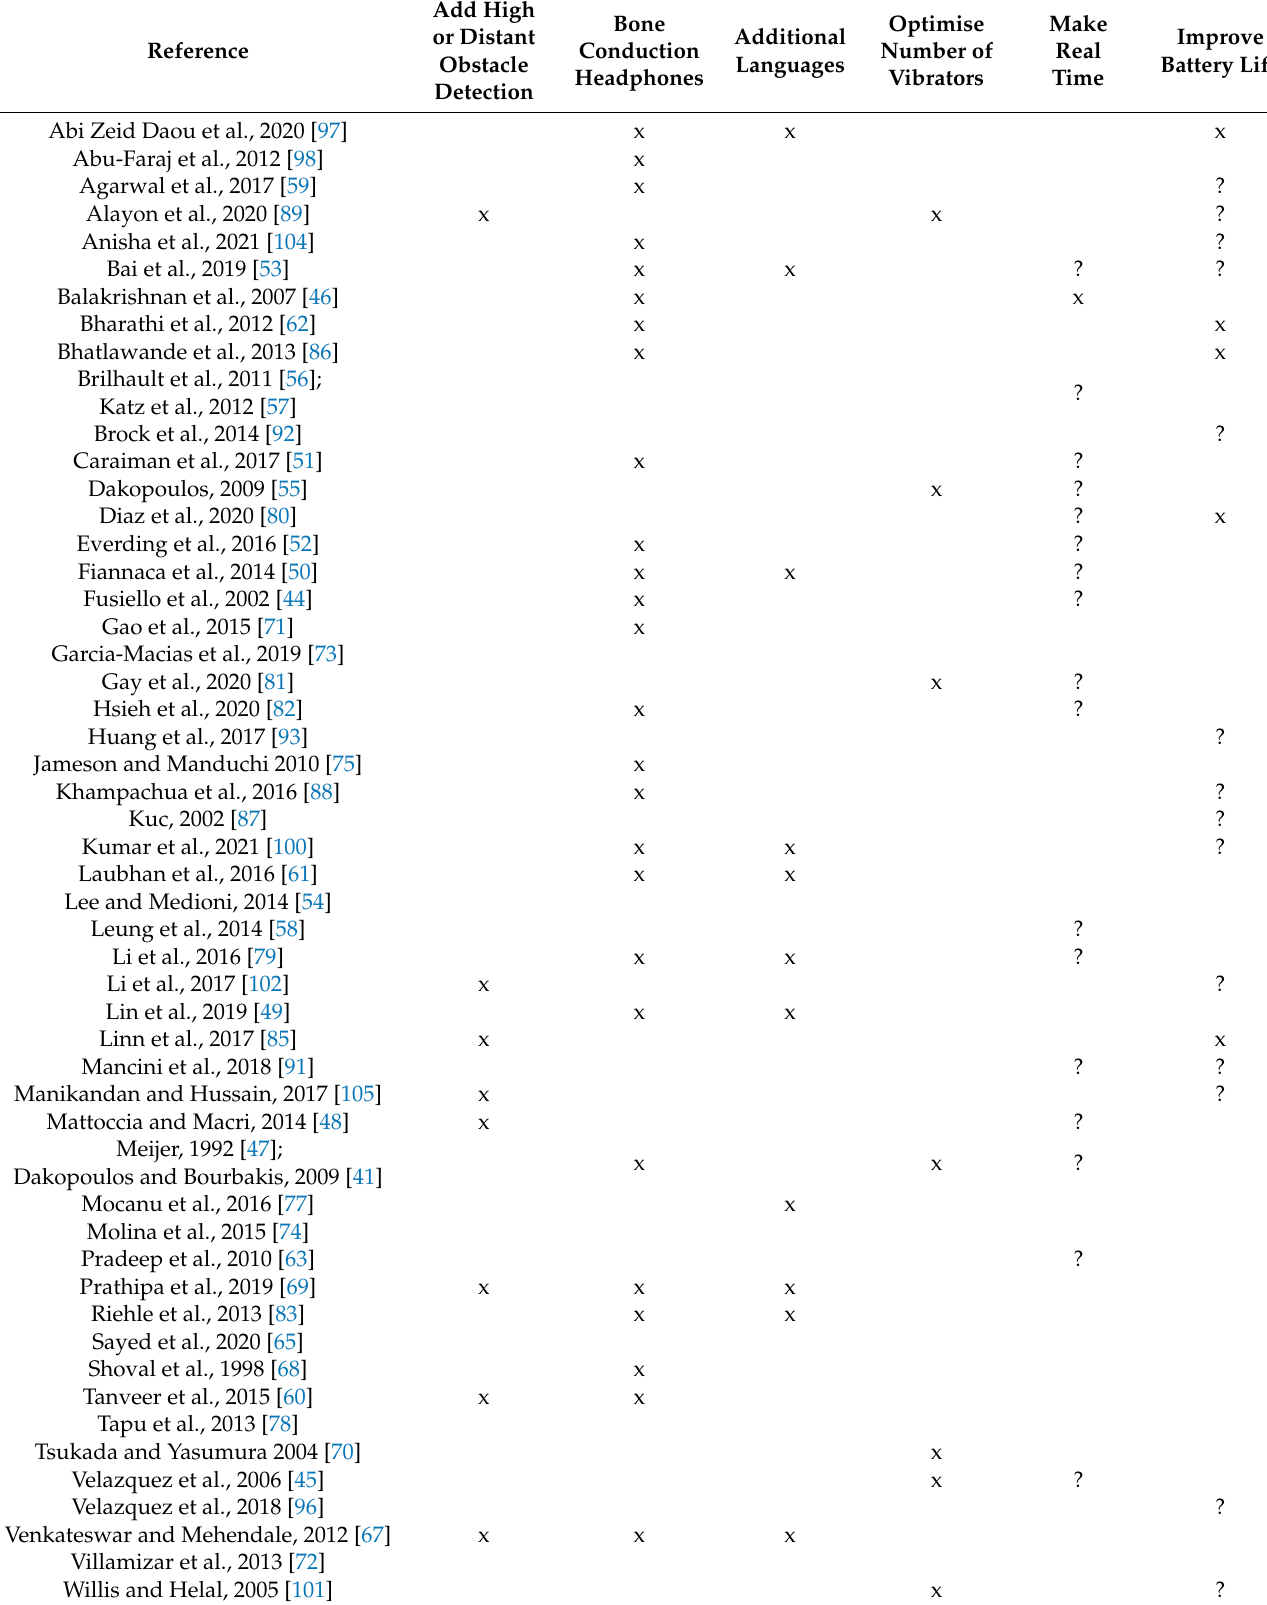
Table 8. Suggested improvements in use and